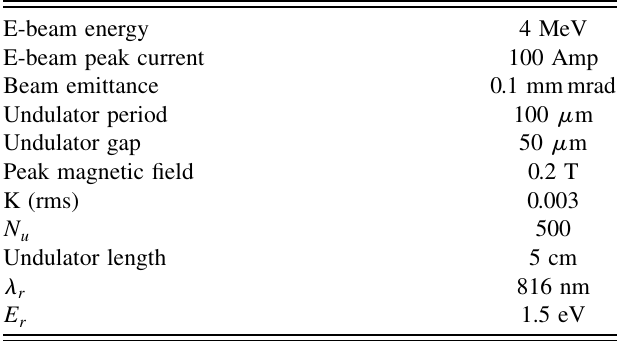
TABLE IV. Parameters of the test experiment for the micro- undulator at the Pegasus beam